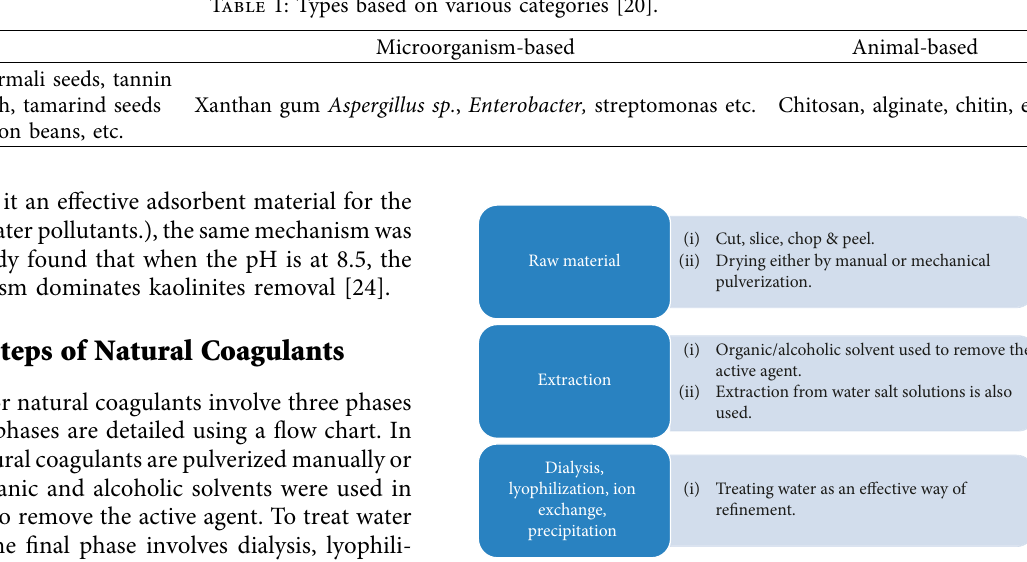
Figure 2: Processes’ phase of natural coagulants.